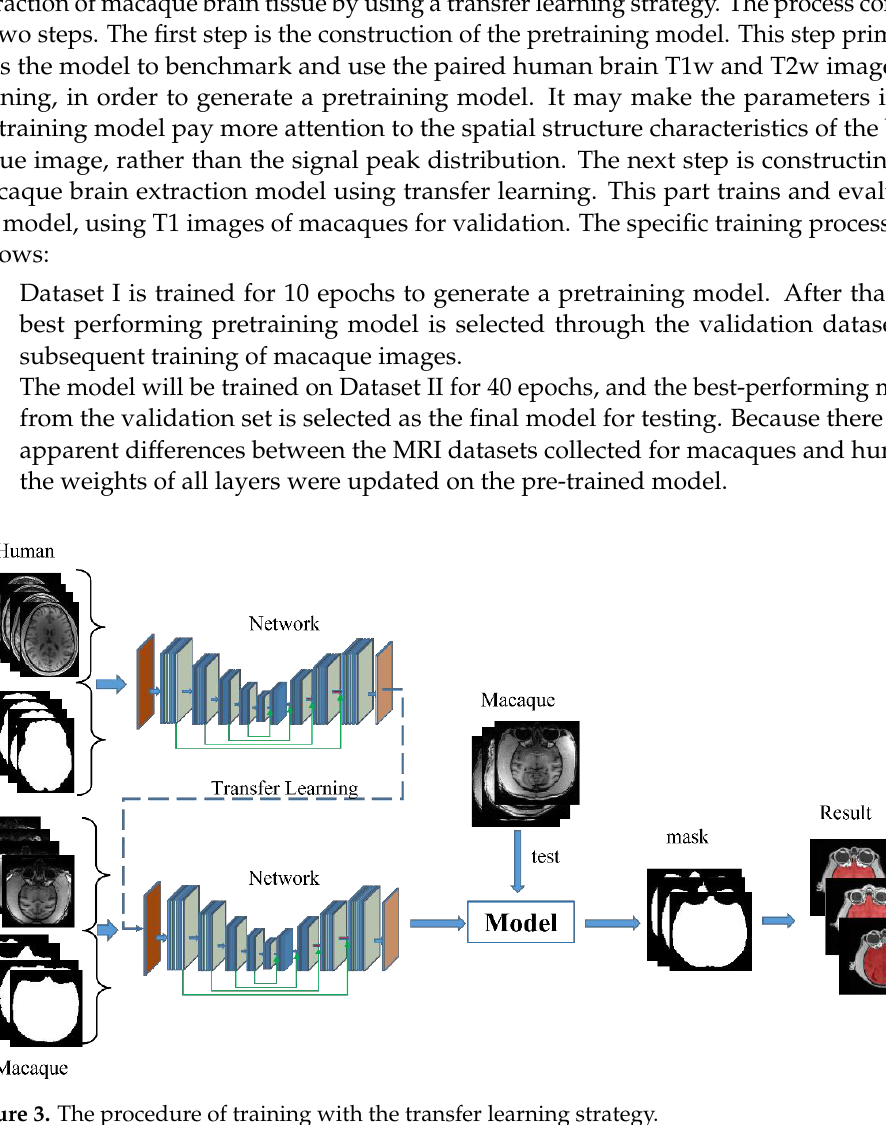
Figure 3. The procedure of training with the transfer learning strategy.